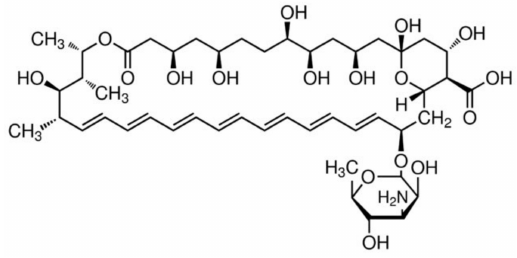
Figure 2. Chemical structure of Amphotericin